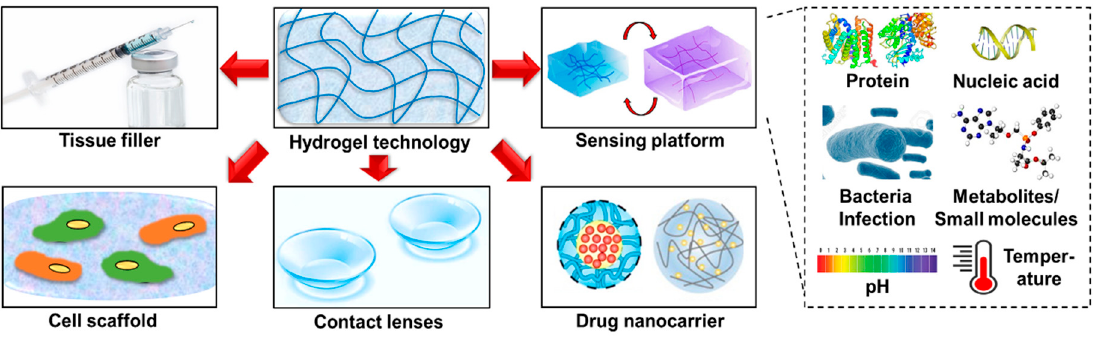
Figure 1 . Summary of biological applications of hydrogels. Figure 1. Summary of biological applications of